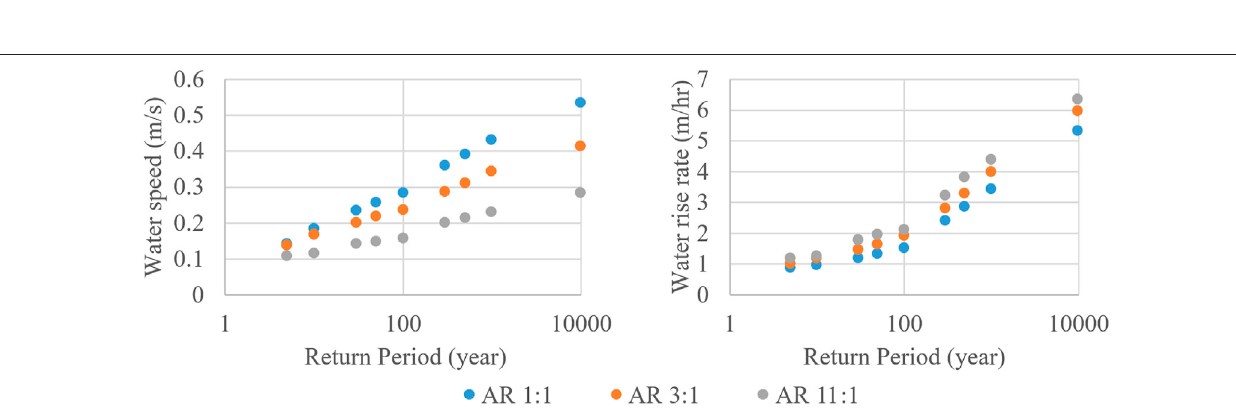
Frontiers in Built Environment |